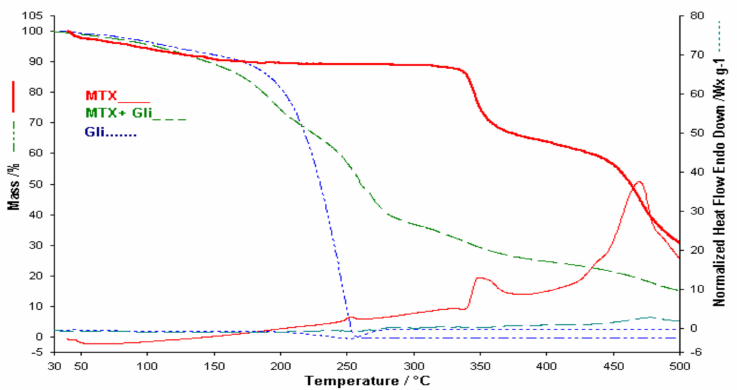
Figure 3. TGA/HF curves for MTX, Gli and Binary mixture.